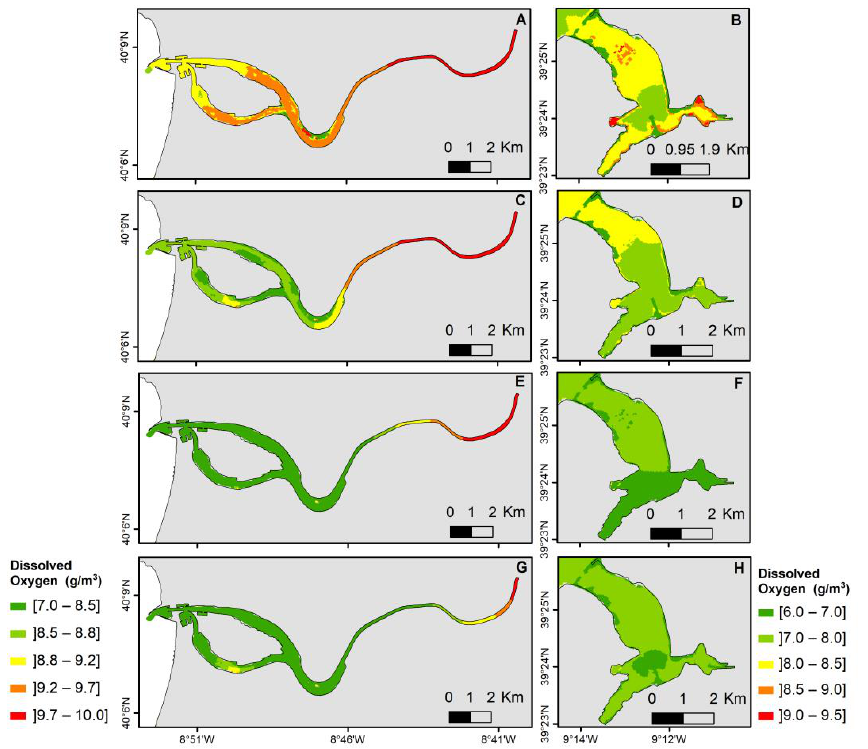
Figure 11. Seasonal mean of dissolved oxygen (g/m 3 ) for Mondego Estuary (left) and Ó bidos Lagoon (right): ( A , B )—winter; ( C , D )—spring; (E , F )—summer; ( G , H )—autumn.